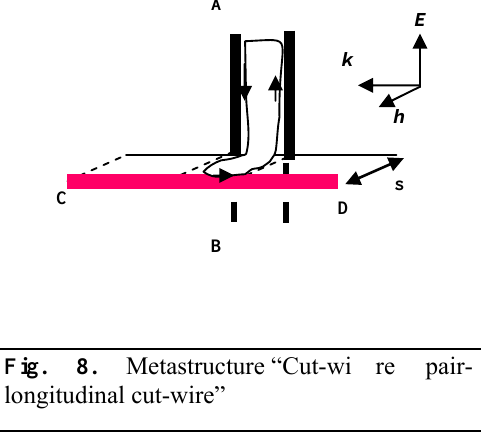
Fig. 8. Metastructure “Cut-wi re pair- longitudinal cut-wire”